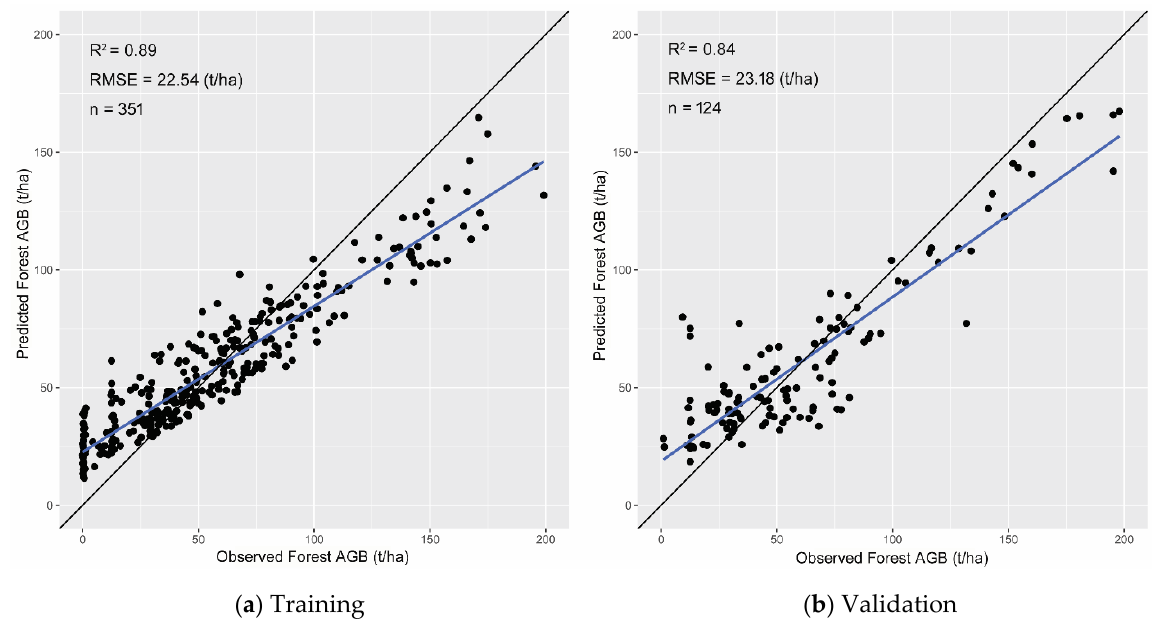
Figure 4. Observed versus predicted forest AGB applying random forest (RF) model and MOD09A1 imagery for ( a ) the training dataset and ( b ) the validation dataset.